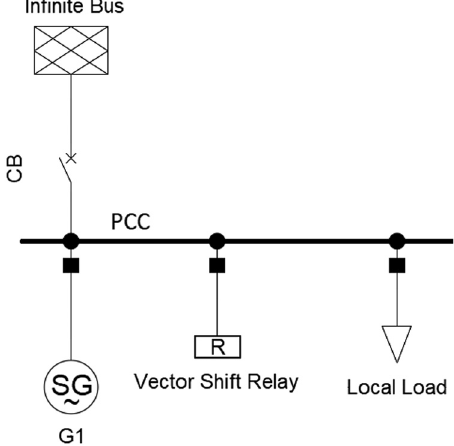
Figure 5: Single line diagram of DG connected parallel to the